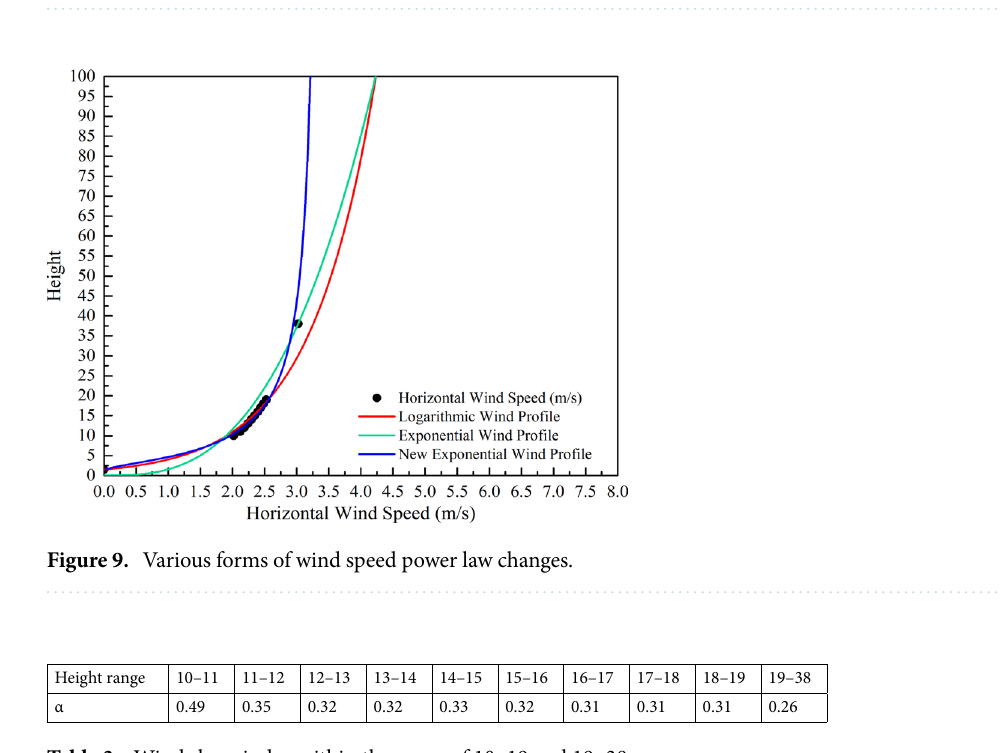
Table 3. Wind shear index within the range of 10–19 and 19–38